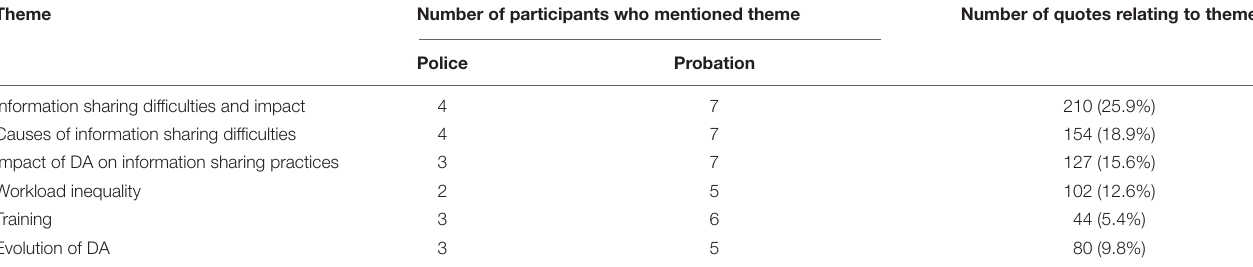
TABLE 1 | Frequency of themes across interviews. Theme Number of participants who mentioned theme Number of quotes relating to